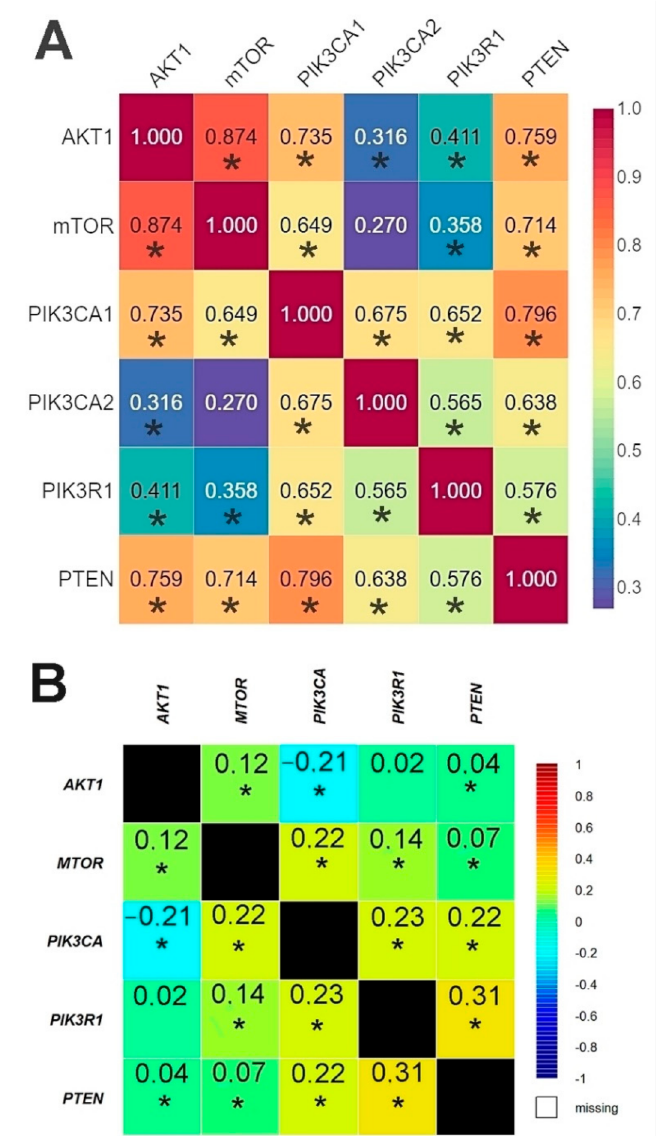
Figure 5. Comparison of the correlation between the expression level of the studied genes in the analyzed patients using Spearman’s rank correlation coefficient ( A ) and patients from TCGA database using Pearson’s correlation coefficient ( B ) (web source the bc-GenExMiner) * p <